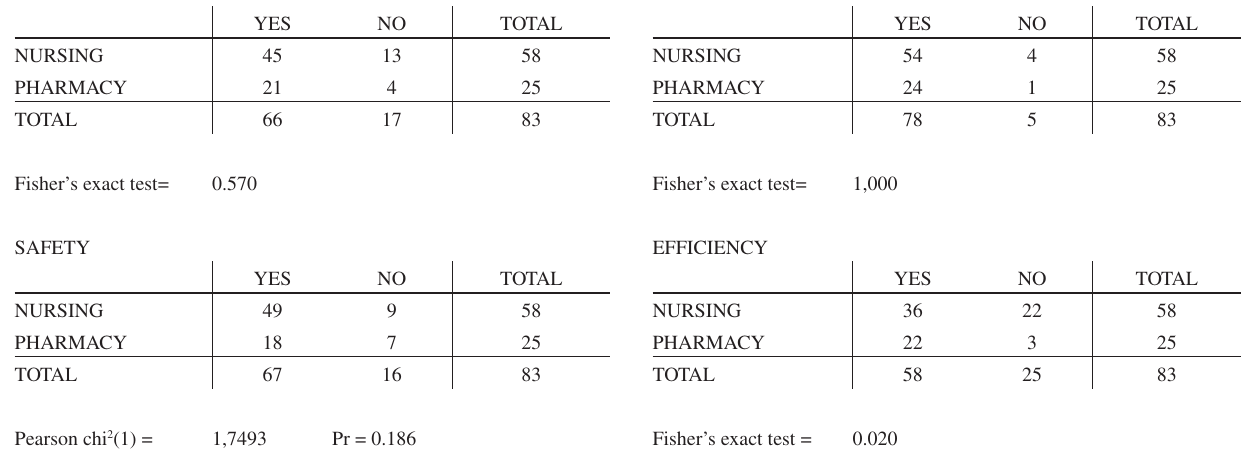
Table 2 - Perceptions of nurses, pharmacists and pharmacy assistants regarding the informatized system, 2004.